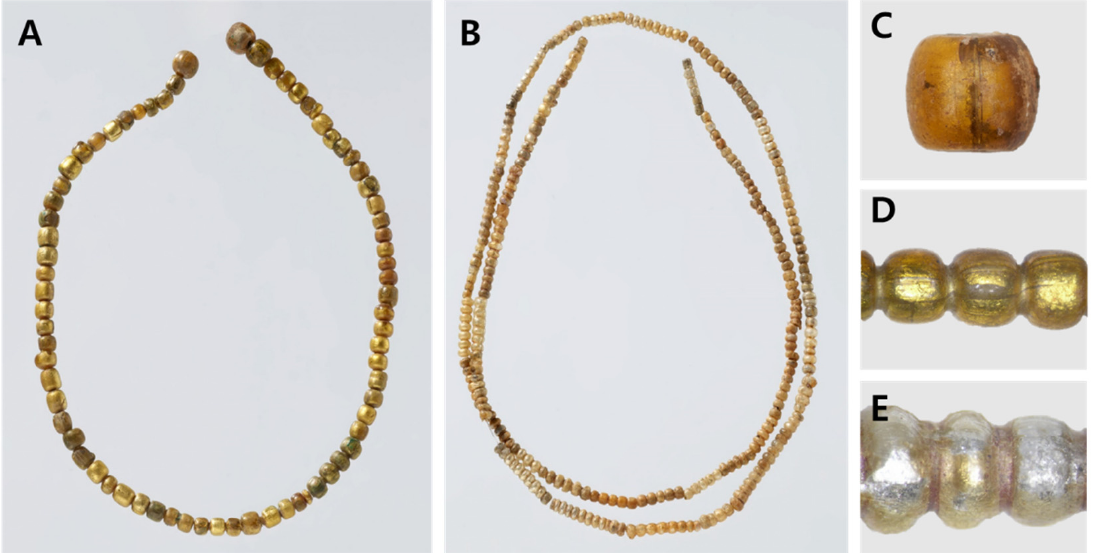
Figure 2. Shape of gold and silver foil glass beads excavated from the tomb of King Muryeong in Korea; ( A ): Gold foil glass beads, ( B ): Sliver foil glass beads, ( C ): Gold foil glass single type, ( D ): Gold foil glass segment type, ( E ): Sliver foil glass segment type.